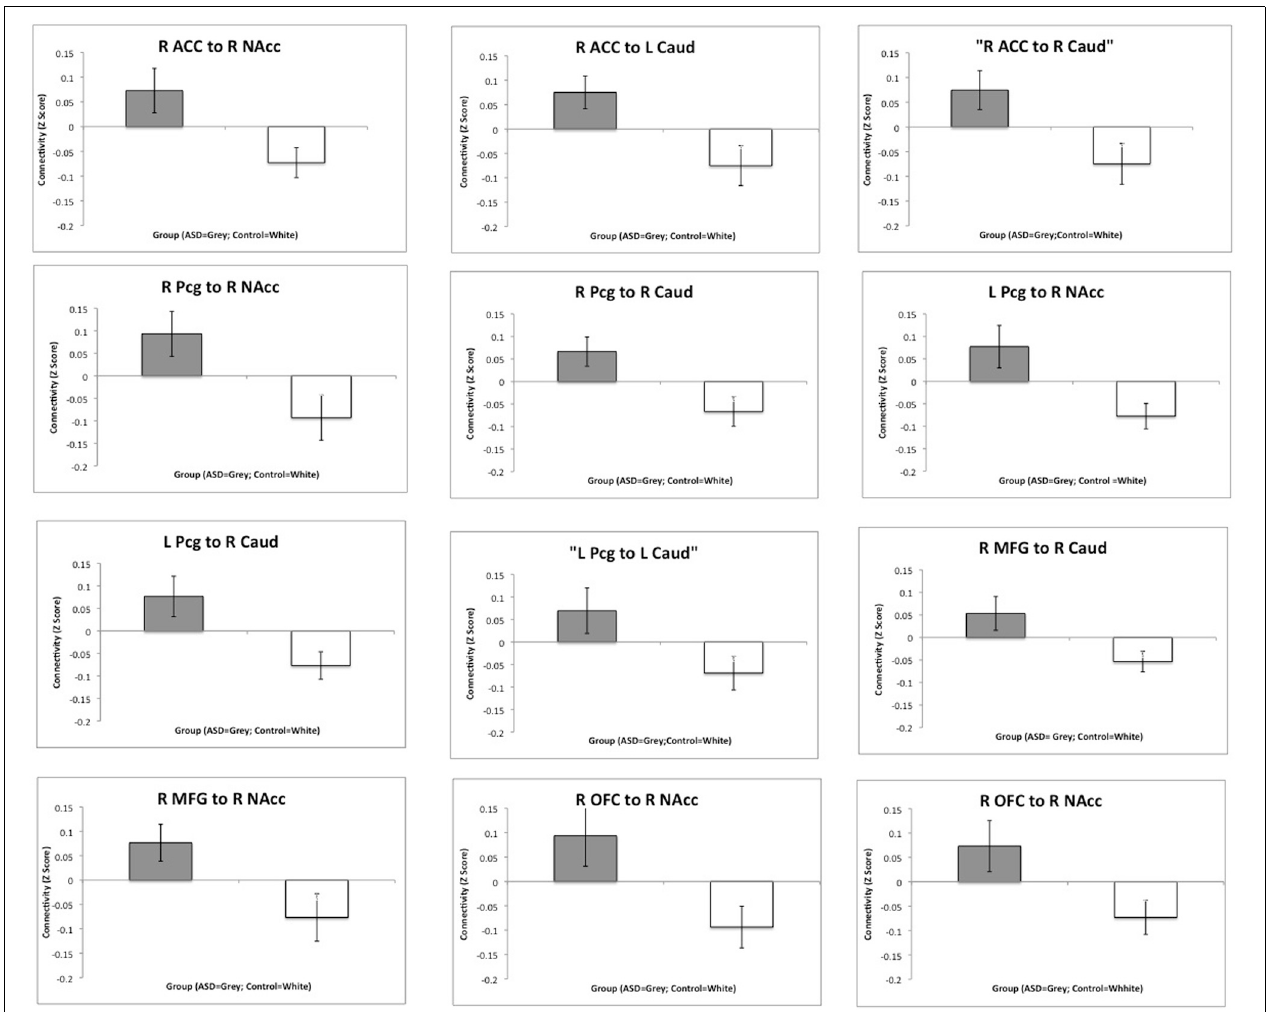
FIGURE 5 | Group differences in functional connectivity between the frontal cortex and the striatum. Bar charts show Z-transformed R -Values for connectivity between each of the regions for which there was a significant group difference, adjusting for age, IQ and frame-wise displacements. The